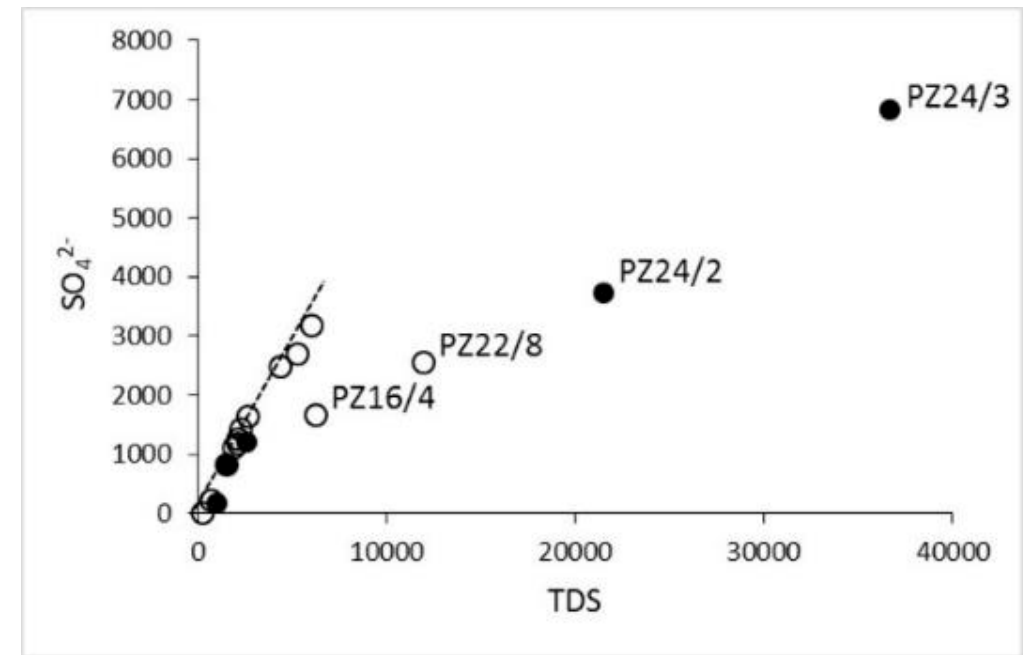
Figure 9. TDS (mg/L) vs. SO 42- (mg/L) correlation diagram. Symbols are: open circle: piezometers with evaporite-rock fragments inside; filled circle: piezometer without evaporite-rock fragments inside. The linear best-fit for waters, excluding the labelled (Na-Cl) samples, is also shown (R 2 =0.97, dashed line). The dissolution of calcium sulphate phases is described by a dissociation reaction such as: − + nH CaSO 4 · nH 2 O ↔ Ca 2 + + SO 2 2 4